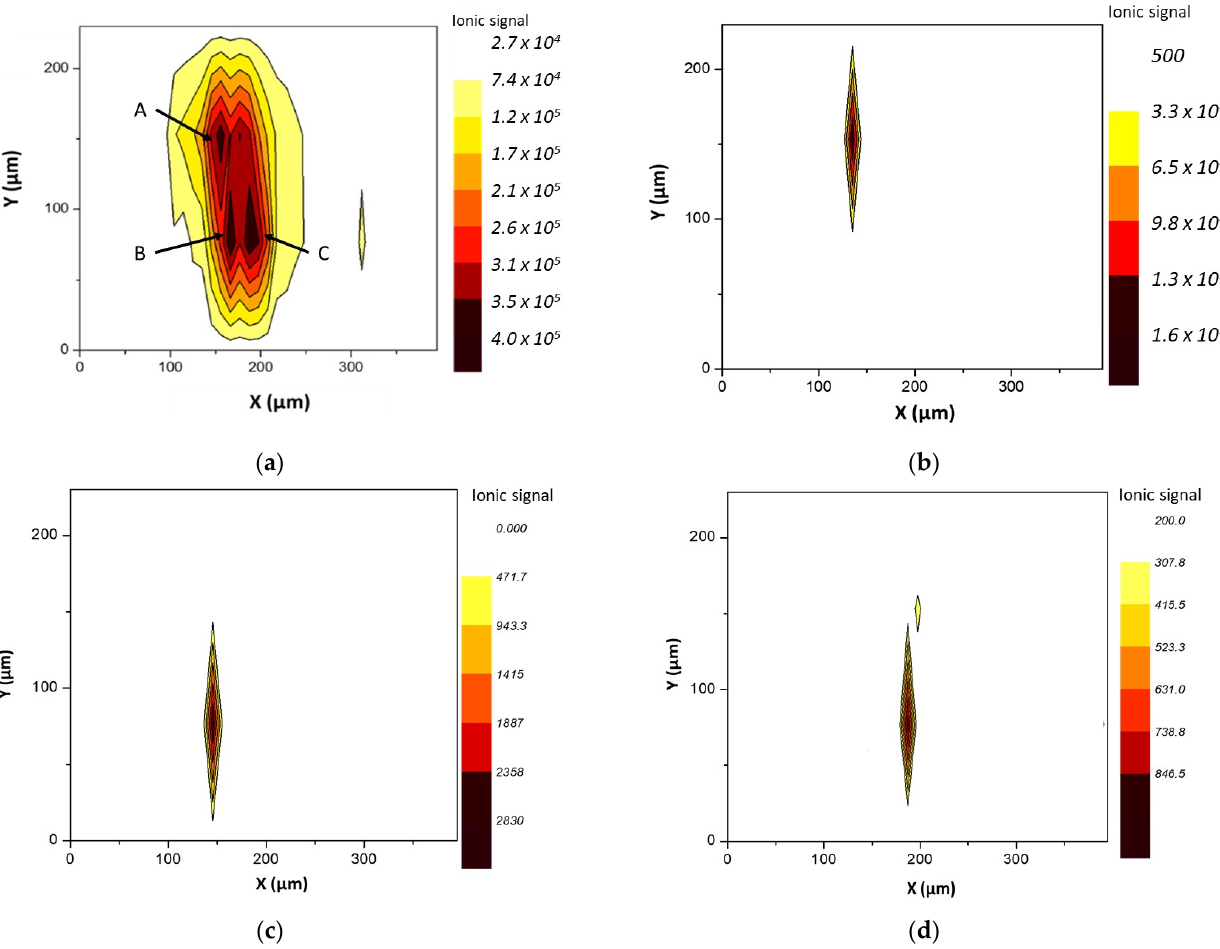
Figure 5. Contour plots for ( a ) 27 Al ( b ) 52 Cr, ( c ) 98 Zr, and ( d ) 208 Pb corresponding to the 4 scan lines performed on defect #1 9 of film # 3.